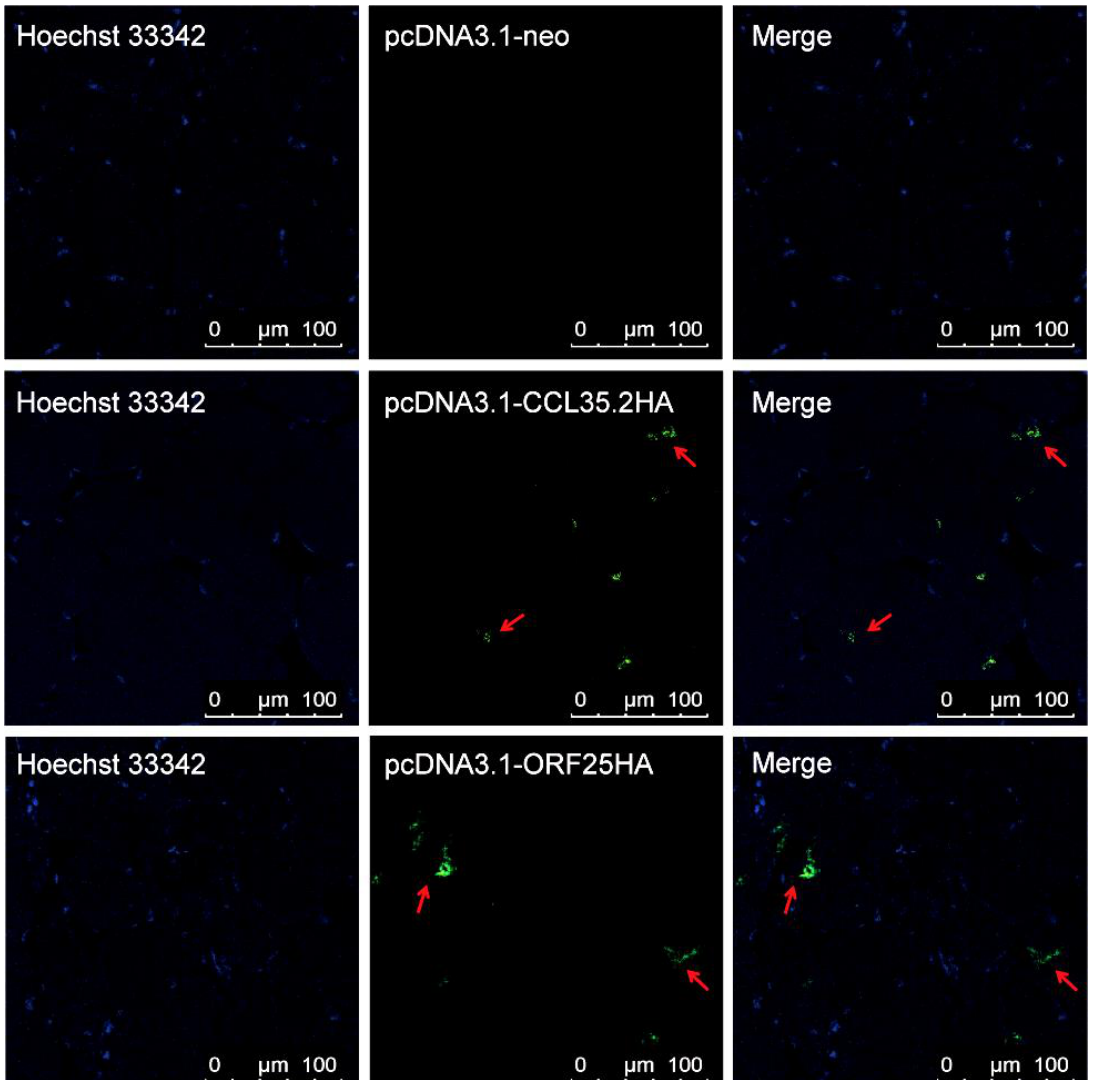
Figure 2. Detection of CCL35.2HA and ORF25HA protein in vivo. The gibel carp were intramuscularly injected with pcDNA3.1-neo, pcCCL35.2 and pcORF25, respectively. The muscle sections were carried out IFAs with mouse anti-HA antibody and goat anti-mouse IgG-FITC (green) second antibody. Cell nuclei were stained by DAPI (blue). The red arrow indicates the specific green fluorescence produced by indirect immunoassay.